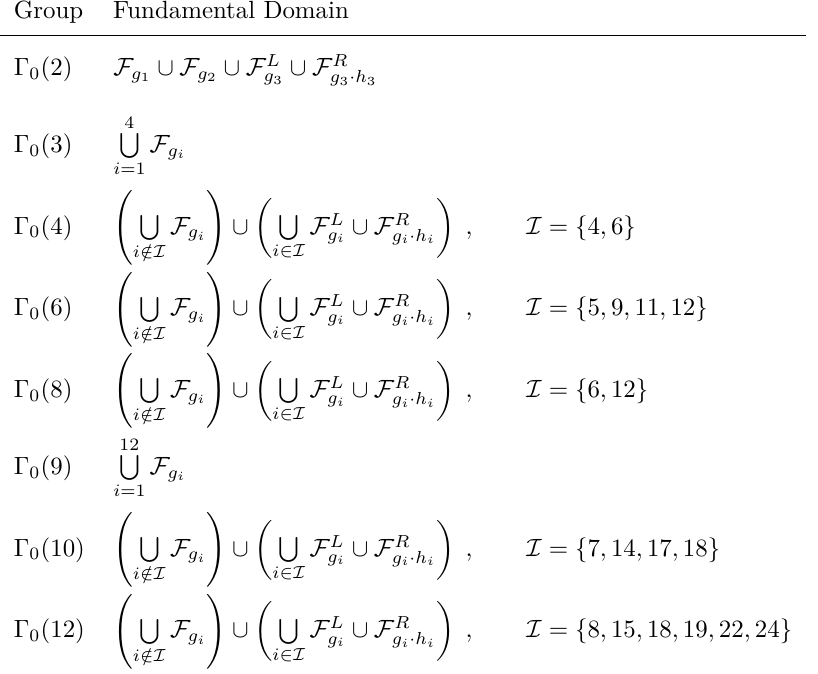
Table 5 . Selected F N -symmetric fundamental domains for Γ 0 ( N ) . The group elements g i and h i are listed in table 3. The resulting fundamental domains are depicted in figures 5, 6, 7, 9 and